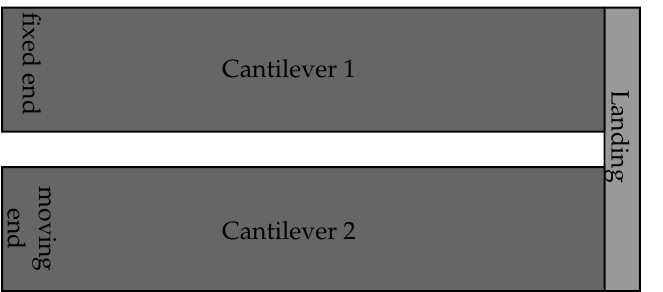
Figure 5. Top view of a 2nd-order cantilever actuator, with the anchored actuator at the top, the landing on the right, and the second actuator at the bottom.